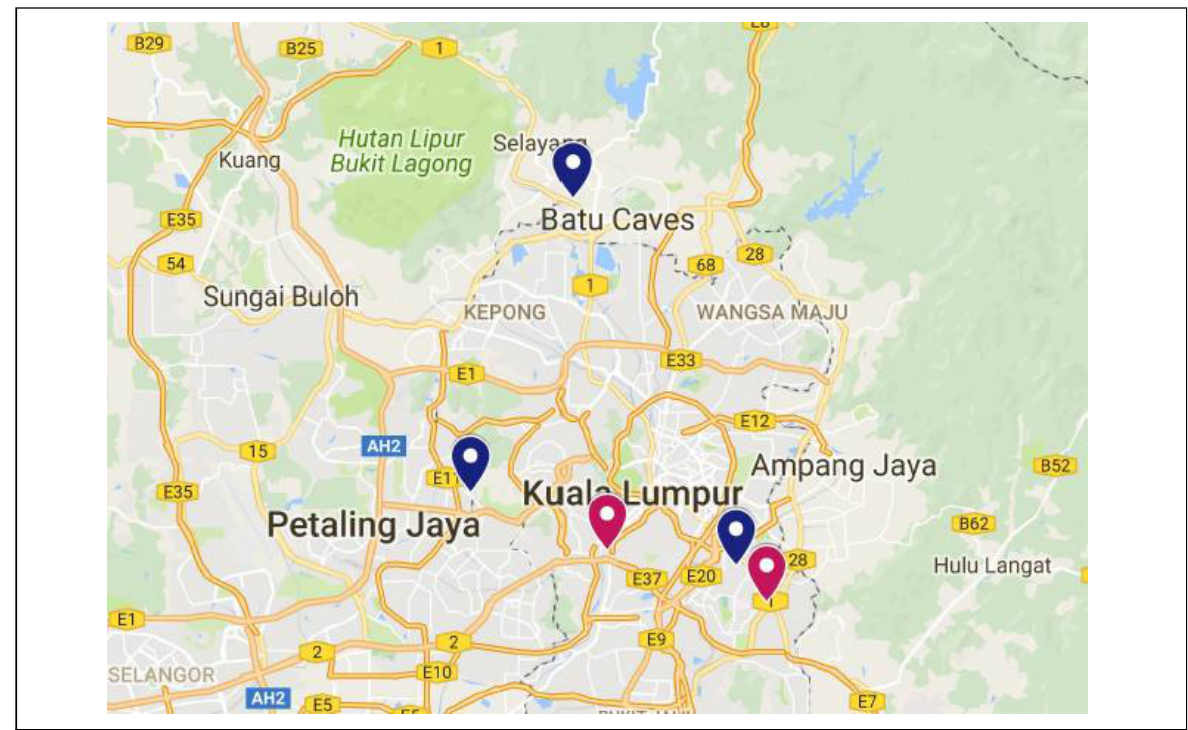
Figure 1: Sampling locations of retail farmed shrimp in Kuala